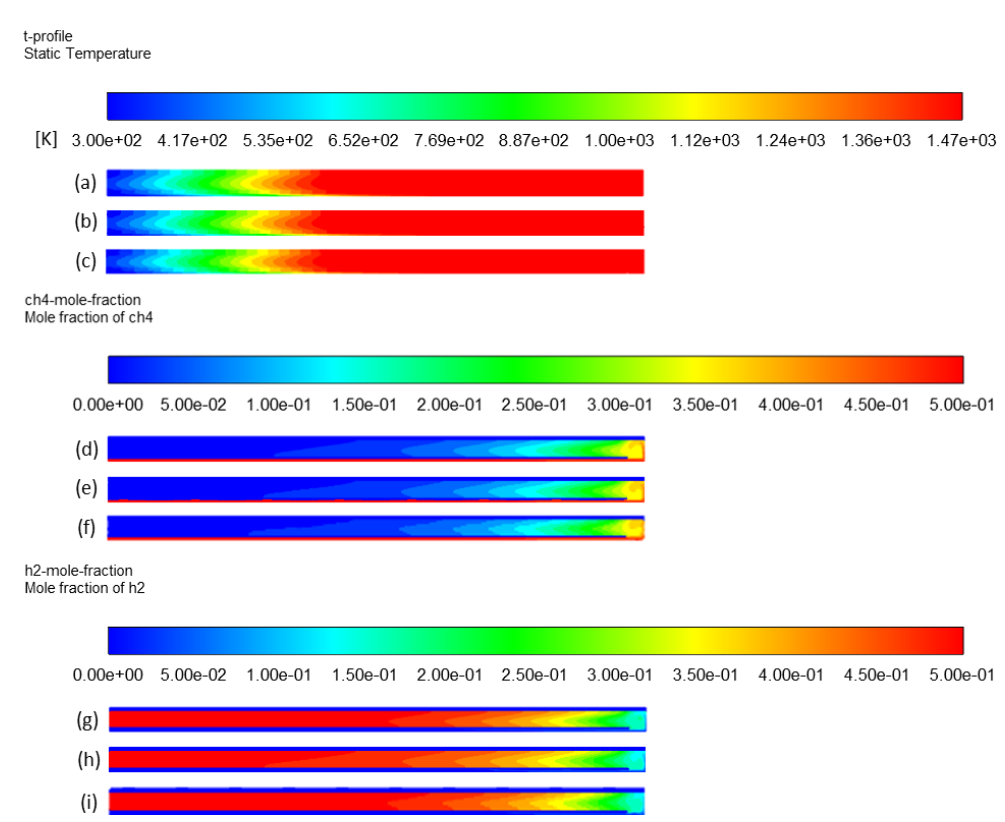
Figure 5. Effect of meshing on temperature profile: ( a ) mesh 1, ( b ) mesh 2, and ( c ) mesh 3; CH 4 mole fraction profile: ( d ) mesh 1, ( e ) mesh 2, and ( f ) mesh 3; H 2 mole fraction profile: ( g ) mesh 1, ( h ) mesh 2, and ( i ) mesh